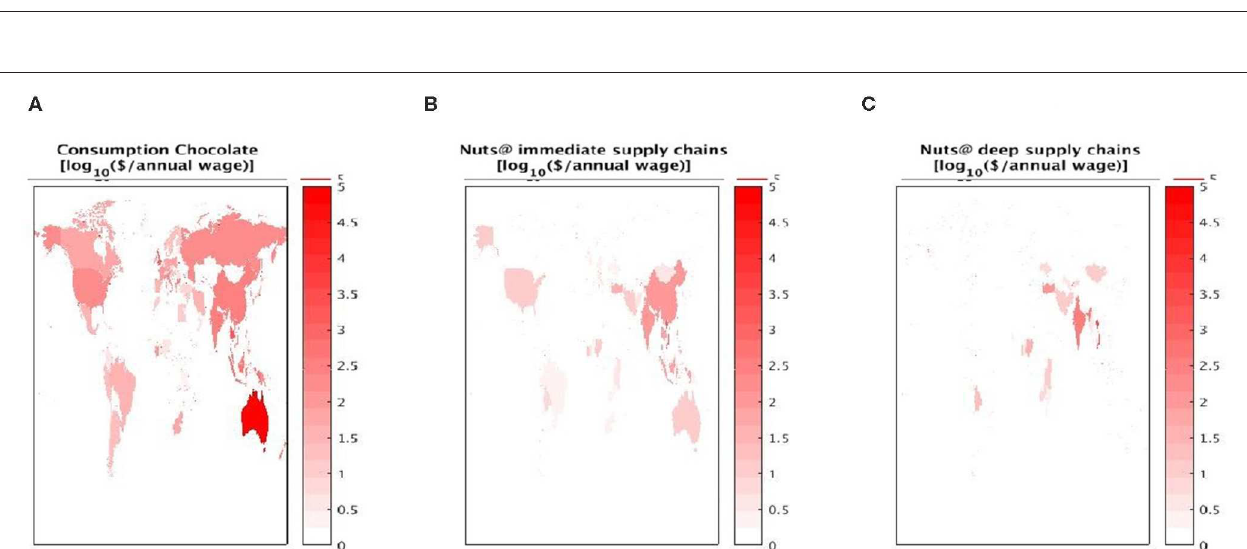
FIGURE 7 | Chocolate consumption and output of nuts. Consumption of chocolate in Australia (A) , and output of nuts in the first 5 supply-chain layers upstream from chocolate (B) , and in the remaining upstream supply chains (C) .